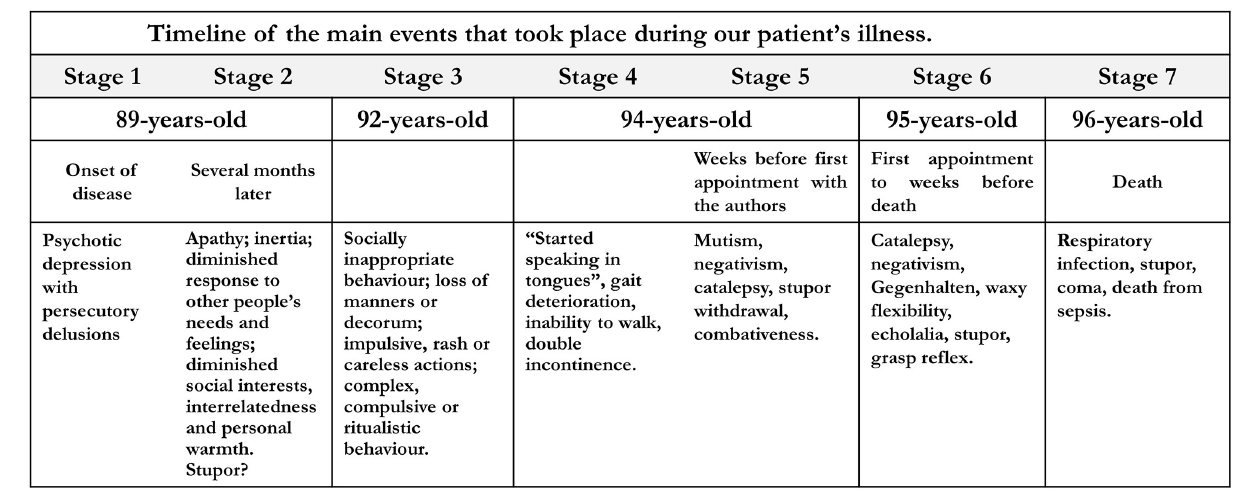
FIGURE 3 | Timeline of the main events that took place during our patient’s